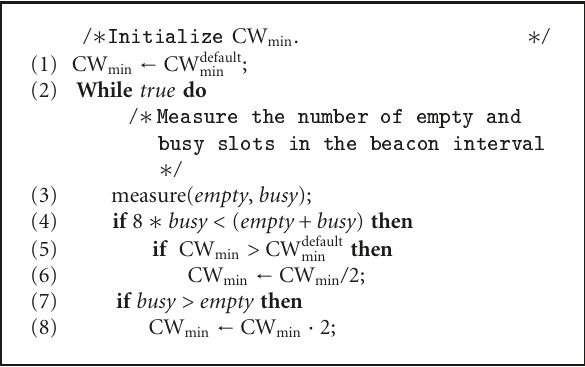
Algorithm 1: CW min adaption in CSMA/ECA.